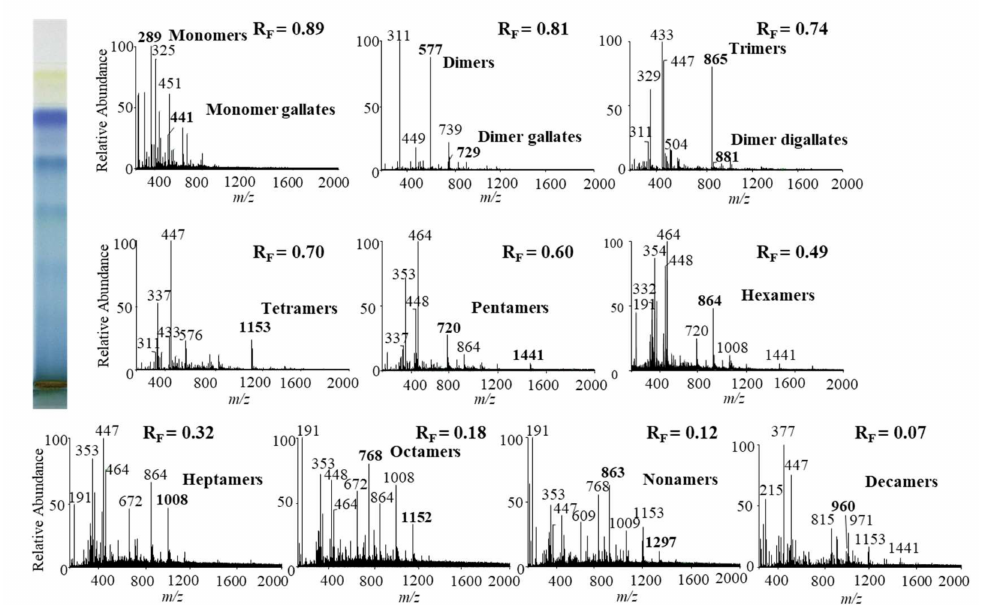
Figure 9. MS spectra obtained by HPTLC-MS analysis of STS from Bohemian knotweed leaves on HPTLC diol F 254S plate pre-developed and developed with acetonitrile. The bolded m / z values in the MS spectra belong to B-type proanthocyanidins and their gallates, which were eluted from the plate with acetonitrile–methanol (2:1, v / v ). A part of the plate was derivatized with DMACA reagent.